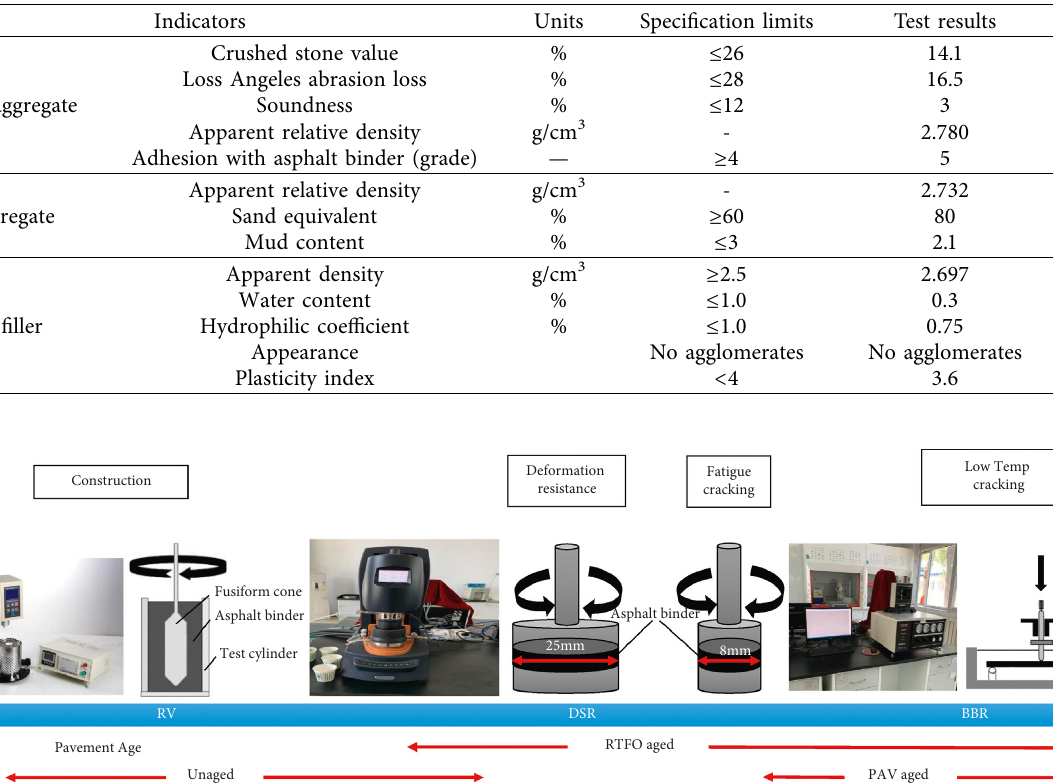
Figure 4: The rheological experiment.